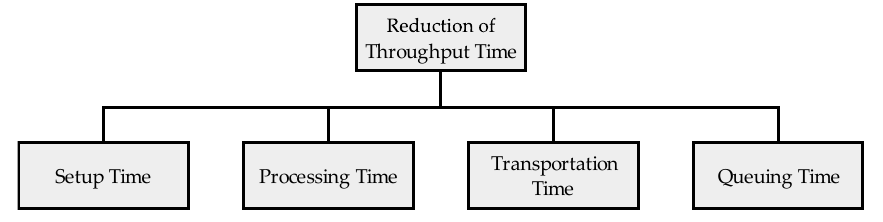
Figure 3. Reduction of manufacturing throughput time per part [18].